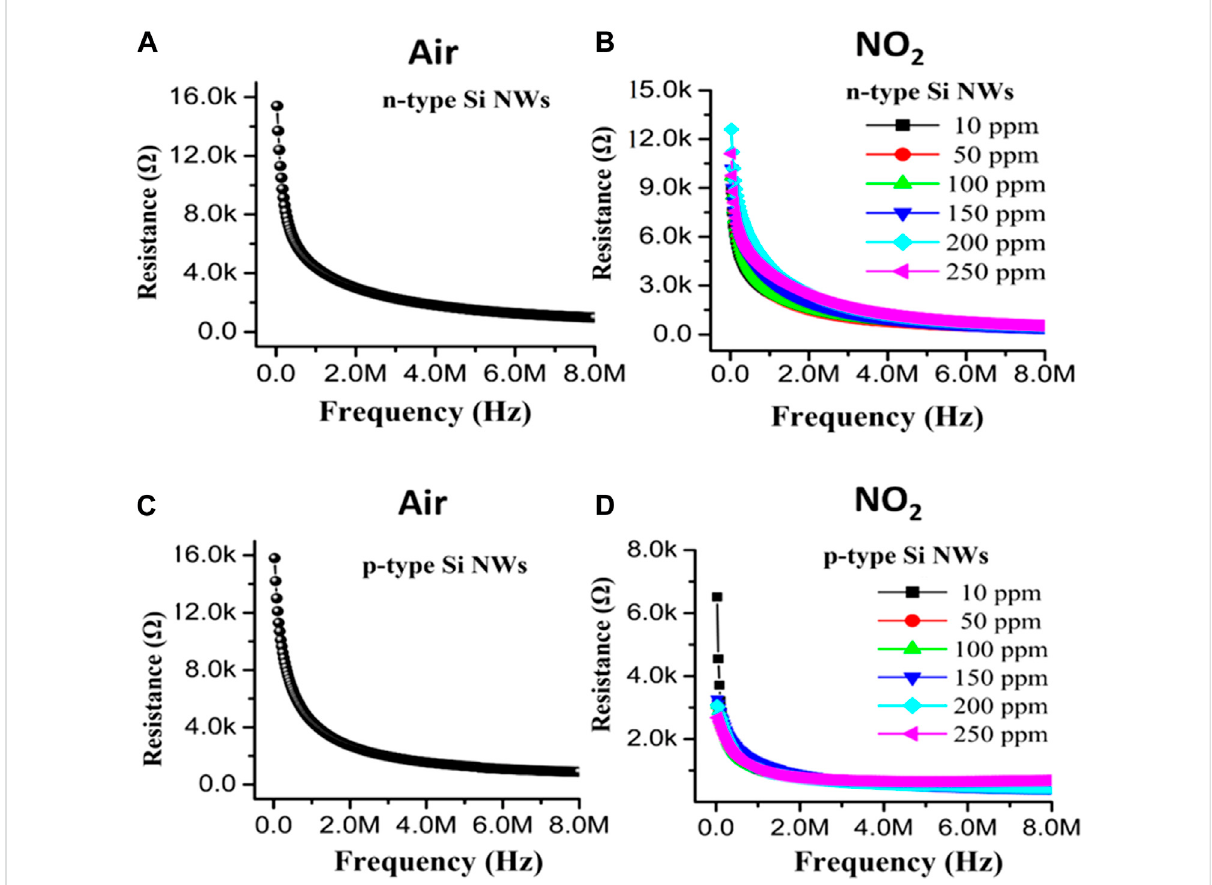
FIGURE 12 Electrical resistance as a function of frequency at 30 ℃ in air atmosphere for (A) the n 40 -type Si NW and (C) the p 40 -type Si NW. Electrical resistance as a function of frequency with varying NO 2 concentrations for (B) the n 40 Si NW and (D) the p 40 Si